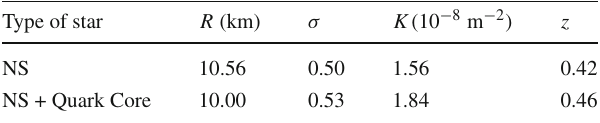
Table 4 Properties of neutron star with the gravitational mass equal to 1 . 8 M (cid:2) for NS and NS+Q Type of